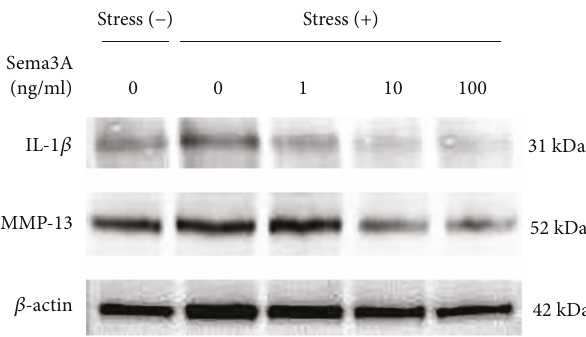
Figure 5: E ff ect of Sema3A on protein expression of IL-1 β and MMP-13 under excessive mechanical stress. ATDC5 cells treated with various concentrations of Sema3A were subjected to excessive CTS for 24h. Protein expression of IL-1 β and MMP-13 was determined by Western blot analysis. β -actin was used as a loading control.